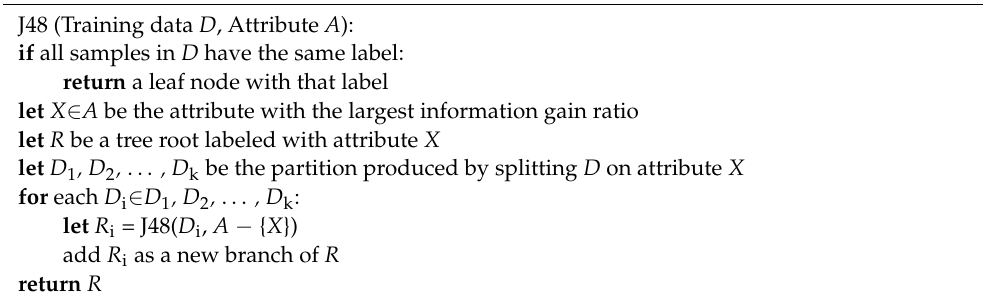
Algorithm 1 Pseudocode of the J48 algorithm